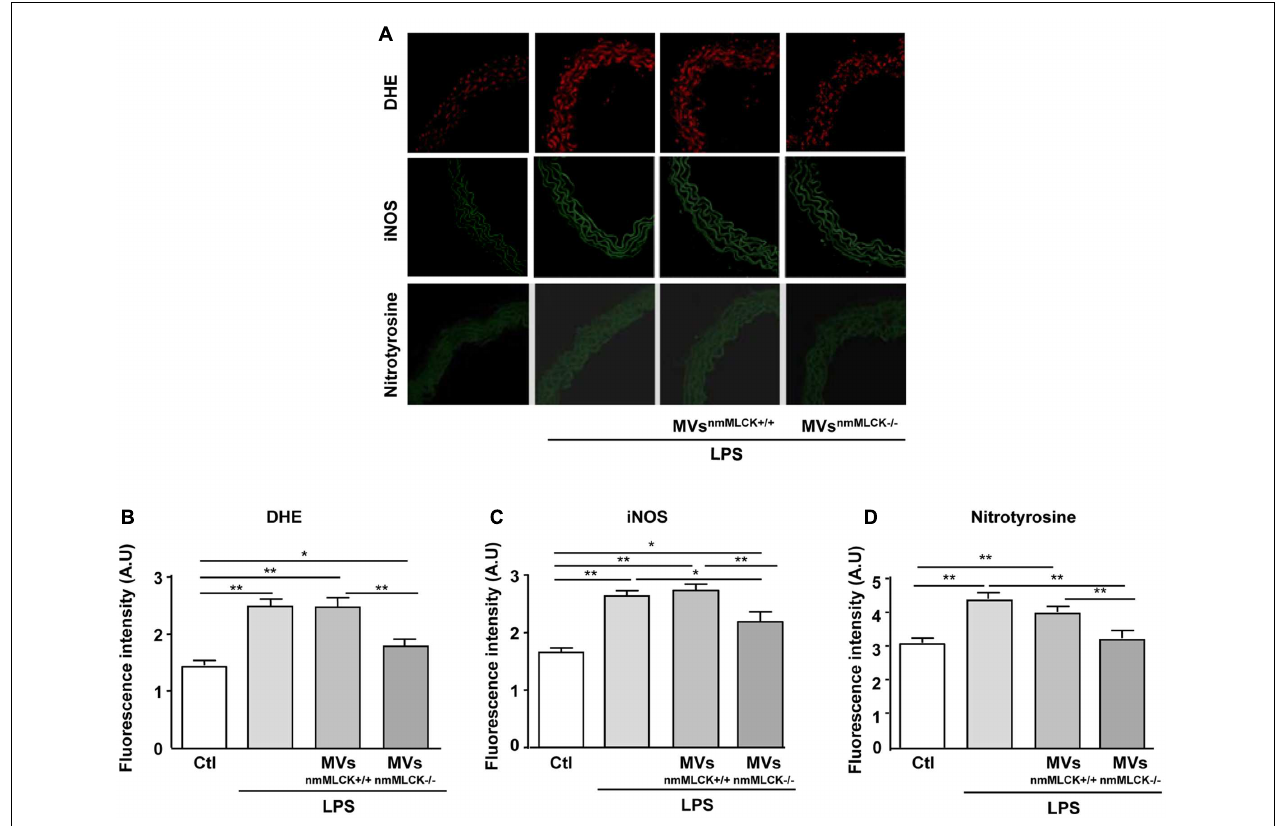
FIGURE 4 | Microvesicles from non-muscular myosin light chain kinase-deficient mice (MVs nmMLCK − / − ) reduce the LPS-evoked oxidative and nitrative stresses in mouse aorta. (A) Confocal image staining of DHE (red), iNOS (green), and nitrotyrosine expression (green) in mouse wild type aorta exposed 24 h ex vivo to saline salt solution, LPS alone (10 µ g/ml), LPS + MVs nmMLCK + / + or LPS + MVs nmMLCK − / − . Aorta was imaged using confocal microscope. (B–D) Histograms show fluorescence intensity of aorta DHE staining (B) , iNOS (C) , and nitrotyrosine (D) assessed by Image J. Data represent arbitrary units (A.U.) of the mean ± SEM ( n = 3–5). ∗ P < 0.05, ∗∗ P <